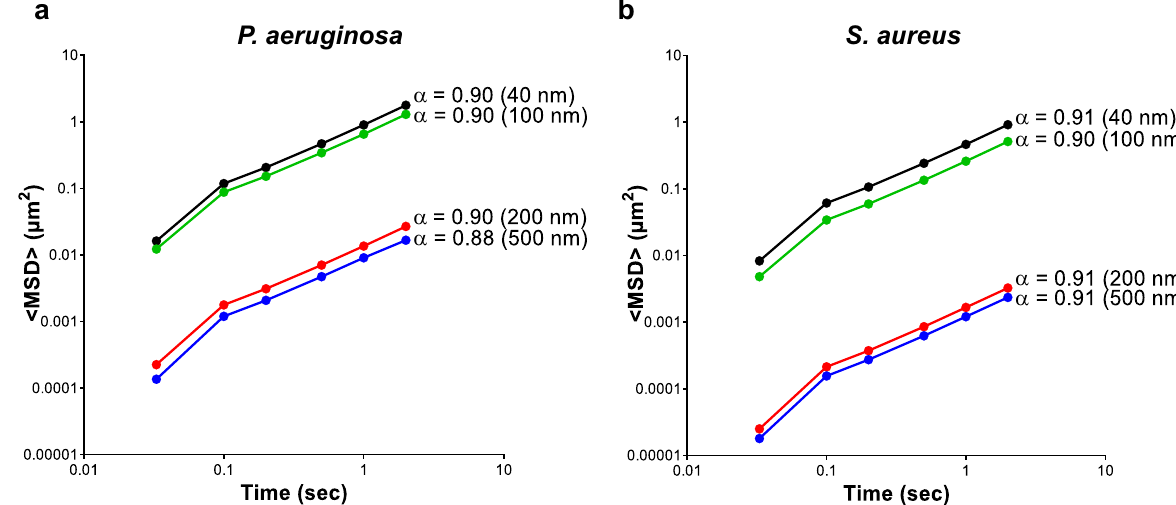
Fig. 2 Exponential anomalous values < α > of P. aeruginosa PAO1 and S. aureus 1004A (MRSA) bio fi lms. Exponential anomalous values < α > of a P. aeruginosa and b S. aureus bio fi lms using 40, 100, 200 and 500 nm negatively charged carboxylate-modi fi ed Fluo Spheres ® . α is measured based on the relation between the ensemble mean square displacement <MSD> versus time scale of the traced Fluo Sphere ® particles and re fl ects the micro-rheological degree of resistance of the bio fi lm towards traced particles where; α > 0.5 indicates viscous resistance; α < 0.5 indicates elastic resistance. <MSD> represents the geometric mean of MSDs of 360 particles ( n = 3, each 120